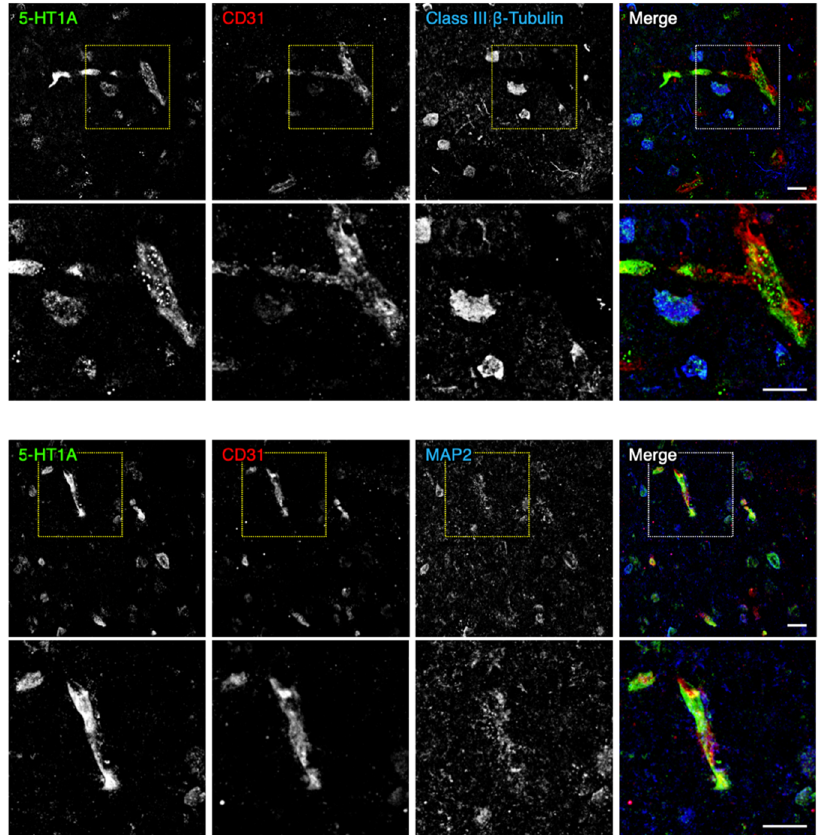
Figure 1. Expression of the 5-HT1A receptor in the microvascular endothelial and perivascular cells of the normal human prefrontal cortex (PFC). Confocal images of the normal PFC gray matter stained for 5-HT1A and CD31 together with either class III β -tubulin or microtubule-associated protein 2 (MAP2). Scale bars, 50 µm.